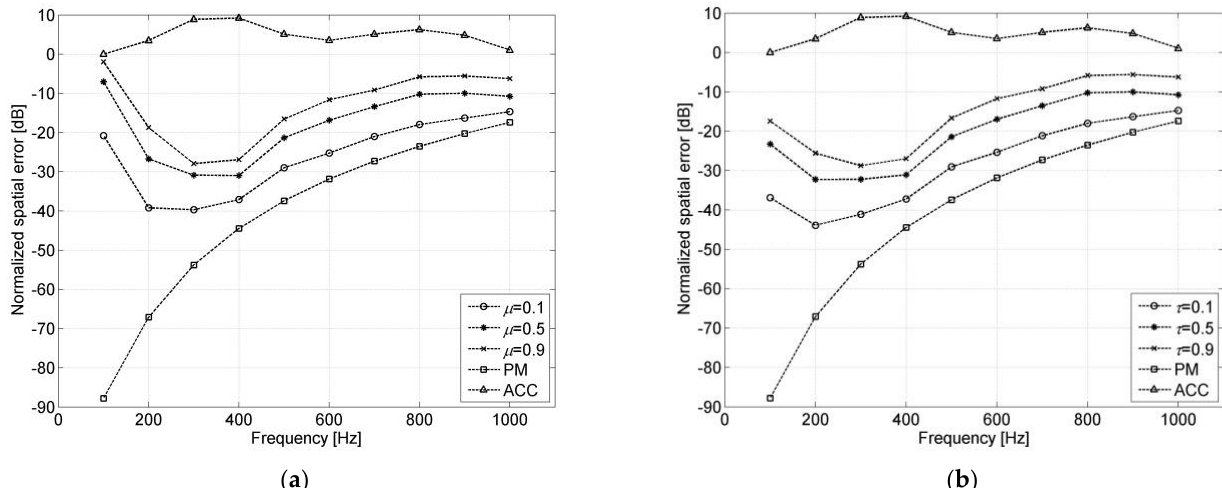
Figure 8. Normalized spatial average error of different methods for three-dimensional experiment. ( a ): PM method in bright zone, ACC method, the first proposed method, with µ = 0.1, 0.5 and 0.9, respectively; ( b ): PM method in bright zone, ACC method, the second proposed method, with τ = 0.1, 0.5 and 0.9, respectively.